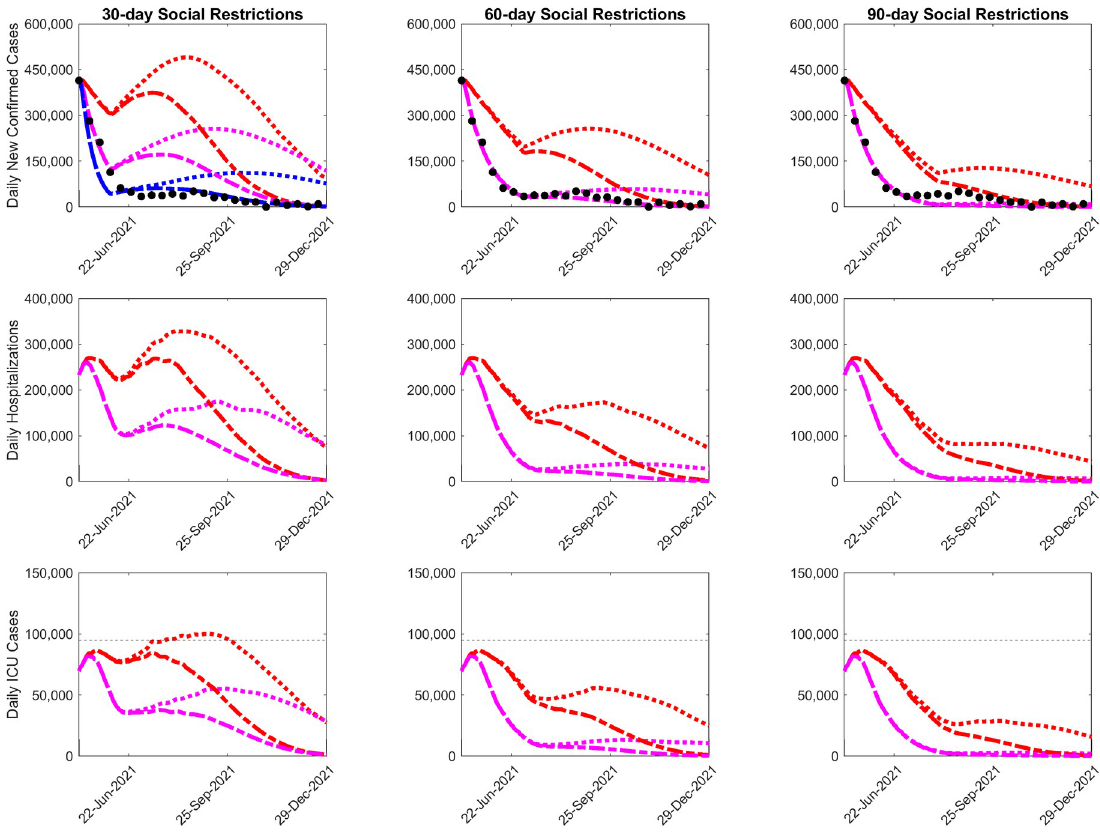
Fig 4. Long-term median predictions of daily new confirmed cases, hospitalizations, and ICU, given 30-day, 60-day, and 90-day period of social restrictions. Four scenarios are shown: 1) (Red dotted curve) a 25% increase in social measures along with the vaccination rate prevailing in May 2021, 2) (Red dot-dash curve) a 25% increase in social measures, with a biweekly 50% ramp in first-dose vaccination rate up to 3x the May 2021 rate, 3) (Magenta dotted curve) a 50% increase in social measures with the May 2021 vaccination rate, and 4) (Magenta dot-dash curve) a 50% increase in social measures, with a biweekly 50% ramp in first-dose vaccination rate up to 3x the May rate. On May 5 th , 2021, the 21-day average daily first-dose vaccination rate was approximately 1,470,000 vaccinations per day. This rate was increased by 50% every 2 weeks until 3x, which is approximately 4,420,000 vaccinations per day. Confirmed case data are also shown (black circles, shown every 8 days for clarity). A simulation of strong social measures (75% increase in social measures) is shown in blue for the 30-day lockdown